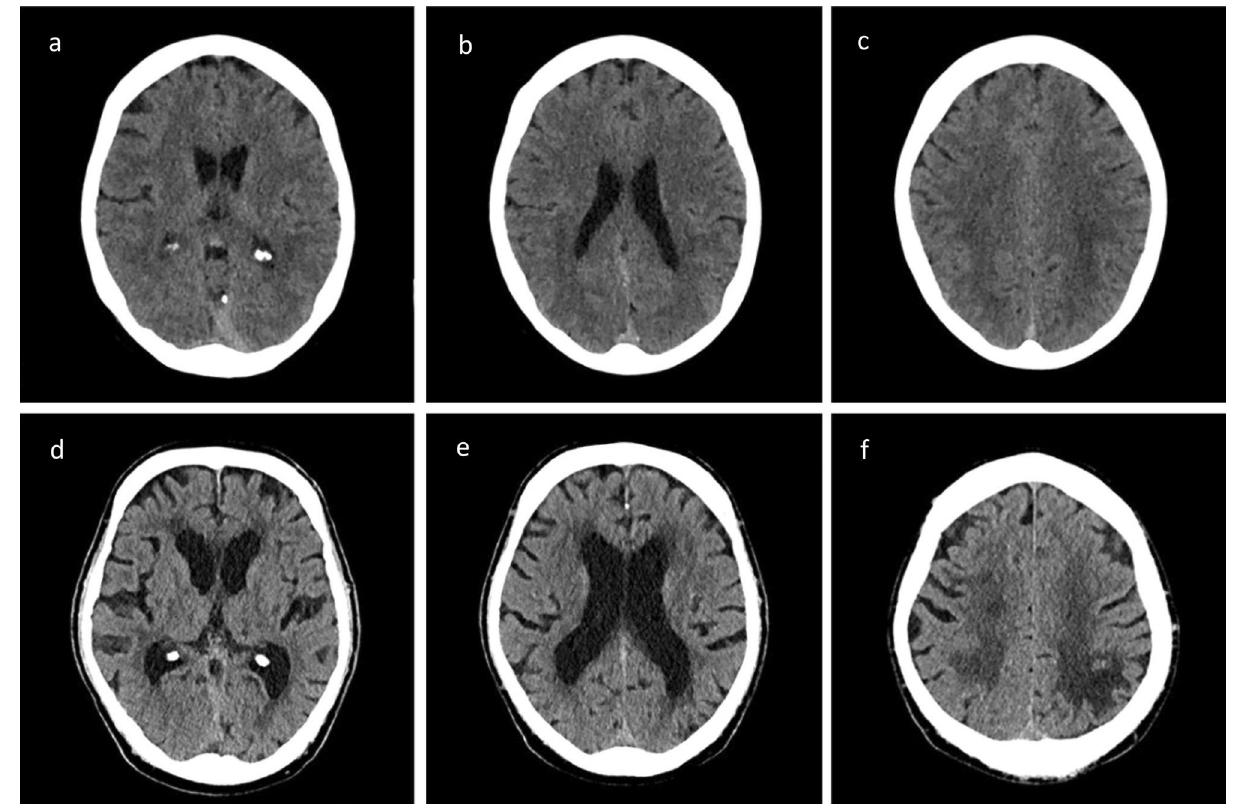
Figure 1. Assessment of the extent of leukoaraiosis in the NCCT using the van Swieten Scale (vSS). ( a – c ) Patient without leukoaraiosis, vSS 0; ( d – f ) patient with severe leukoaraiosis, vSS 4.